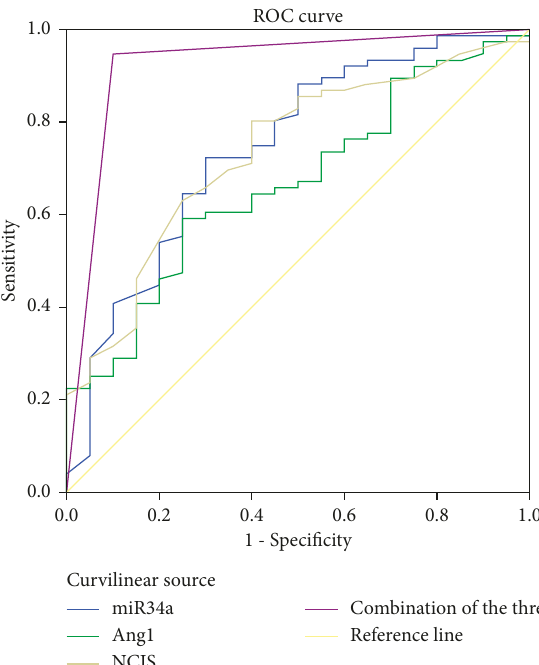
Figure 7: ROC curve analysis of serum miR-34a, Ang-1, and NCIS scores alone and their combined detection to predict death in children with